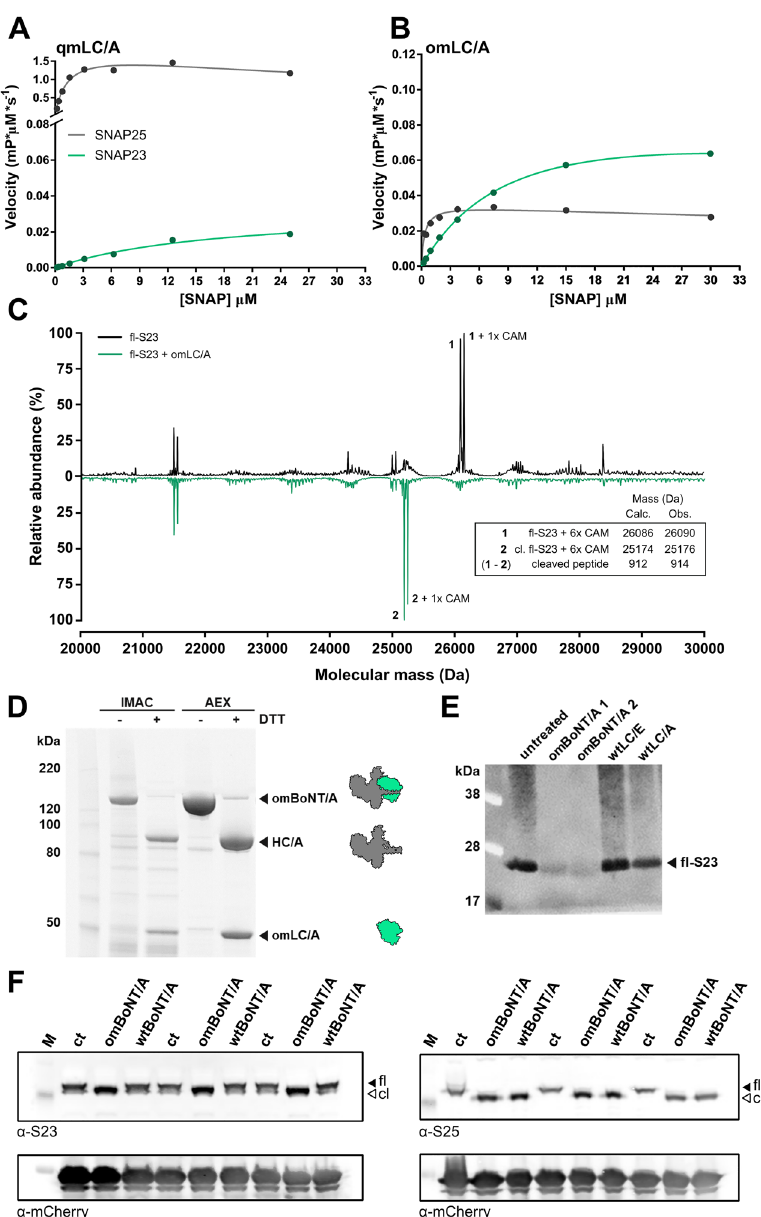
Figure 3. Characterization of omLC/A cleavage. ( A ) Rates of SNAP cleavage by batch-expressed, purified qmLC/A and ( B ) omLC/A at the indicated DARET substrate concentrations (n = 3). ( C ) Deconvoluted ESI–MS of recombinant, full-length SNAP23 (fl-S23) treated with DTT and iodoacetamide to carbamidomethylate its six cysteines (6 × CAM). The mass spectrum of intact fl-S23 incubated with buffer (top, black) is compared to that of fl-S23 incubated with omLC/A (bottom, teal). Intact fl-S23 (1) and cleaved fl-S23 (cl. fl-S23, 2) peaks are labeled. Additional marked peaks correspond to the masses of peaks 1 and 2 plus one additional CAM (+ 57 Da), likely resulting from overalkylation by iodoacetamide 41 . The cleaved peptide was not directly observed, but inferred from the mass difference of peaks 1 and 2. The deconvolution error is +/- 2 Da. ( D ) Recombinant omBoNT/A was purified by IMAC followed by anion exchange (AEX) chromatography. The omBoNT/A is ≈95% nicked upon DTT reduction as demonstrated by the presence of the HC/A and omLC/A bands. ( E ) In vitro cleavage of recombinant fl-S23 by two independent preparations of omBoNT/A (1 and 2) visualized with a C-terminal anti- SNAP23 antibody; before proteolysis, omBoNT/A was reduced with TCEP. The untreated, wtLC/A, and wtLC/E lanes provide negative controls. ( F ) In cellulo cleavage of SNAP23 and SNAP25 in SiMA-H1 cells infected with adenovirus delivering DNA encoding mCherry/SNAP23. Cells were treated with omBoNT/A or wtBoNT/A or without toxin (ct). Proteins, full-length (fl) or cleaved (cl), were identified by Western blotting with anti- SNAP23, -SNAP25, or -mCherry antibodies (M, MW marker). Full-length images of these gels with multiple exposures where necessary are shown in Fig. S12 and